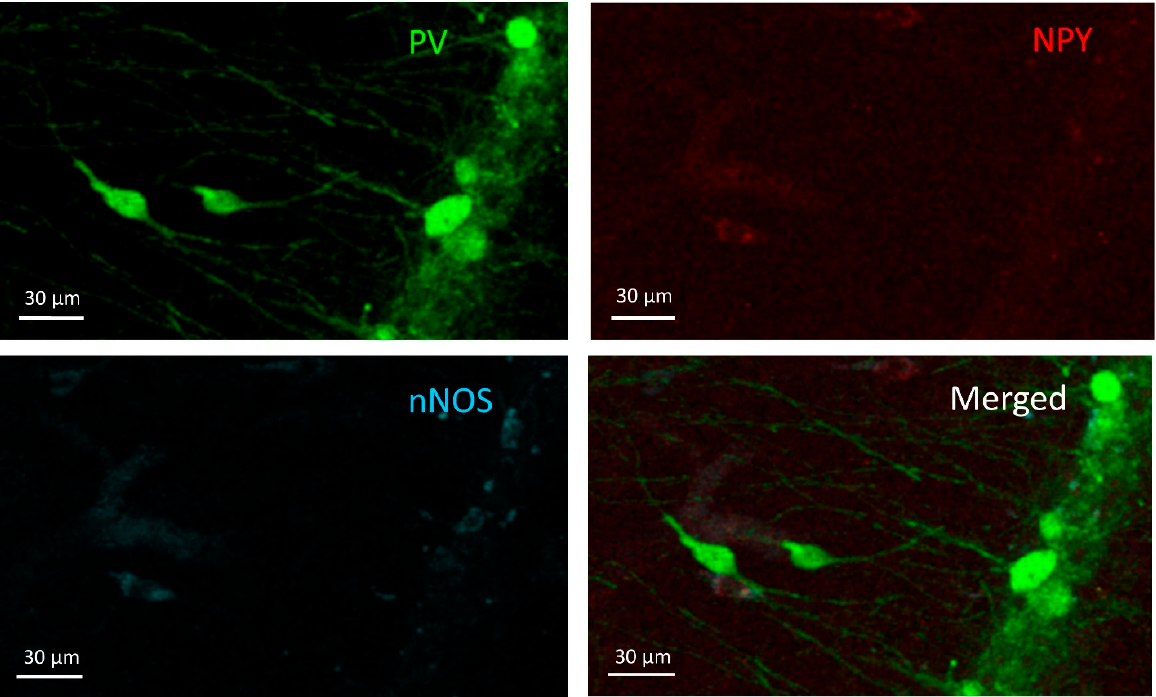
Figure 2. PV+ cells. Two PV+ cells can be seen in the stratum radiatum ( middle-left ) and more PV+ cells in the stratum pyramidale ( right ) on the PV channel image ( green ) but do not appear in the other two channels (NPY-red and nNOS-blue).